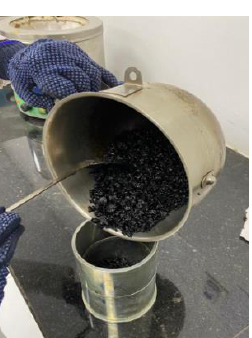
Figure 17. Some equipment used to prepare the asphalt mix